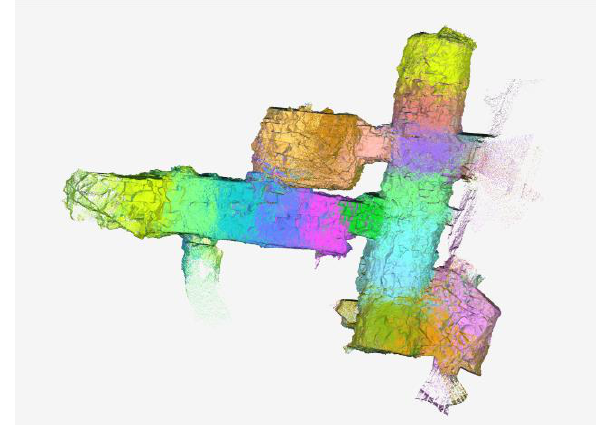
Figure 3. The 18 scans of the tomb interior after being